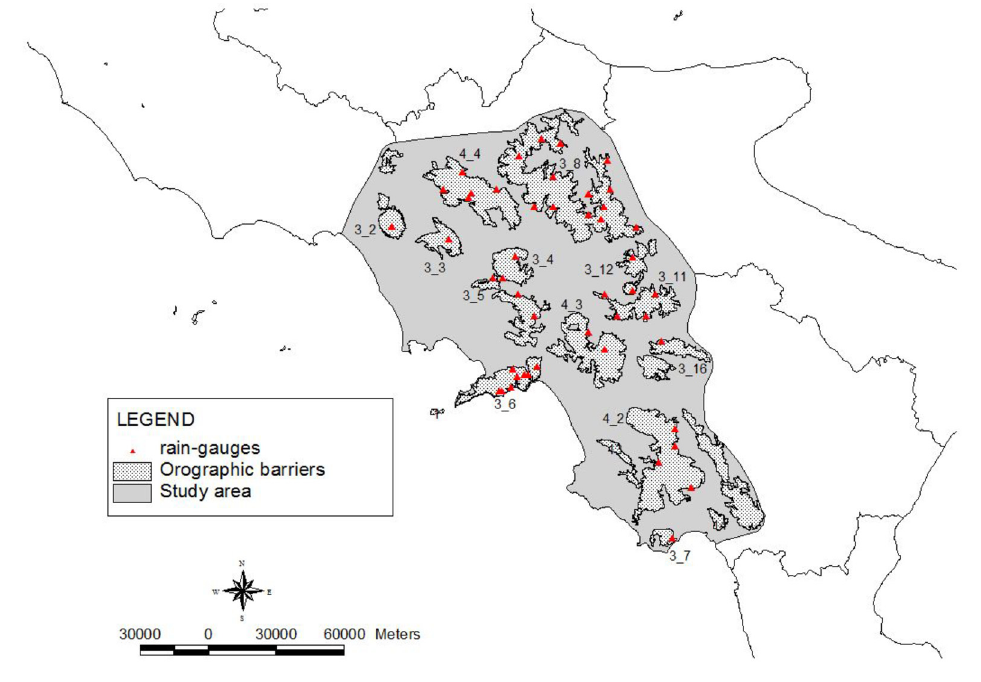
Figure 7. Rain gauges in orographic areas. The orographic shapes are numbered with two digits: the first one denotes the order (groups, 4th order, and systems, 3rd order), the second one identifies progressively the